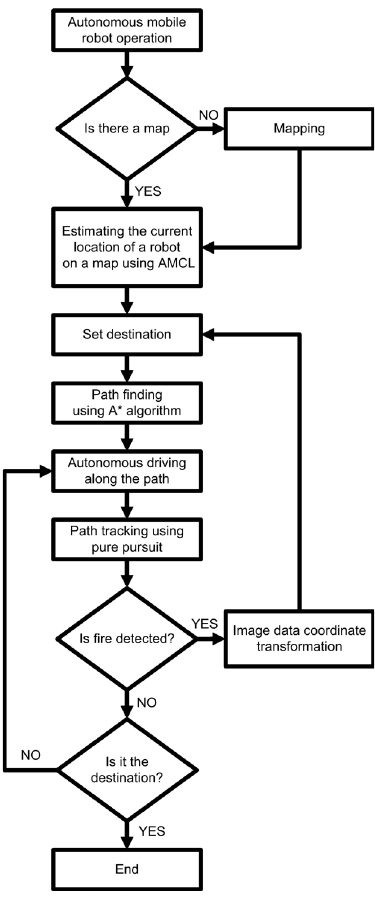
Figure 1. Flowchart of the autonomous mobile robot operation.